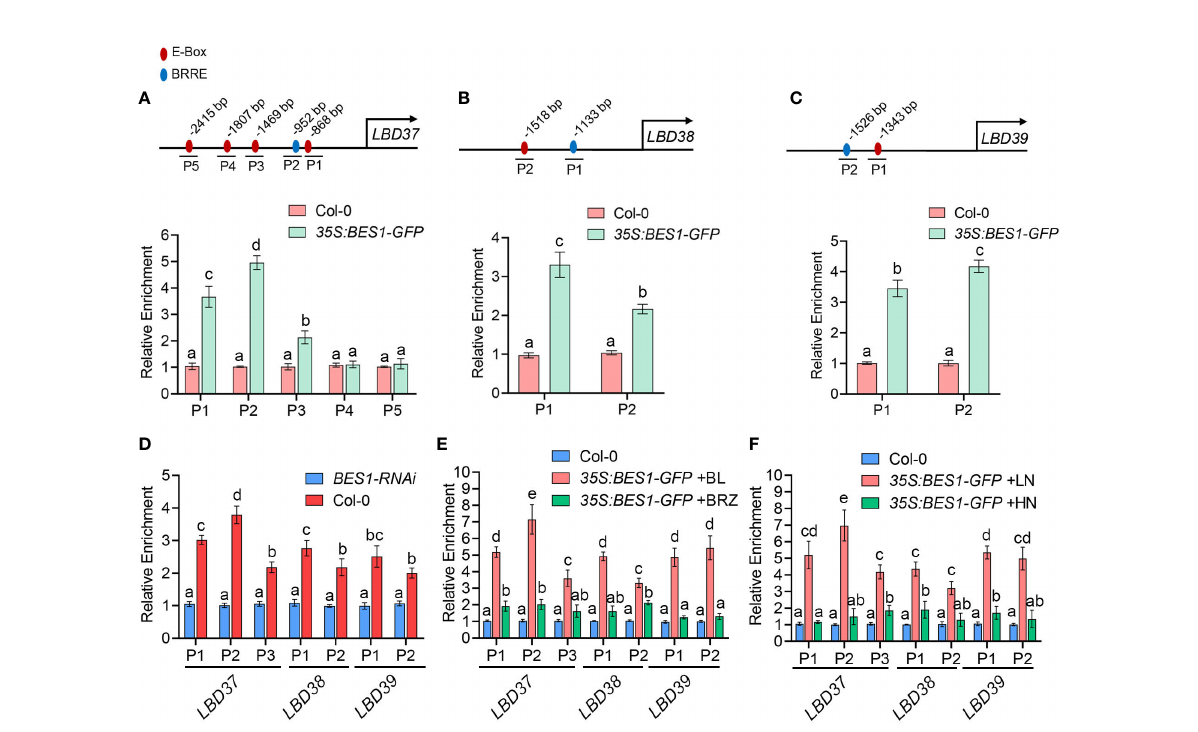
FIGURE 4 ChIP-qPCR showing BES1 binds to BRRE and E-box of LBD37/38/39 promoters in a BR- and LN-enhanced manner. (A-C) Promoter analysis of LBD37/38/39 promoters (top panels) and ChIP-qPCR (bottom panels). The E-box elements were showed as red circles and BRRE elements were showed as blue circles in the LBD37/38/39 promoters. P1-P5 represent the perfect E-box or BRRE sites. The numbers indicate relative position of the E-box or BRRE elements in the respective promoters relative to the ATG start codon. The ChIP assays were performed